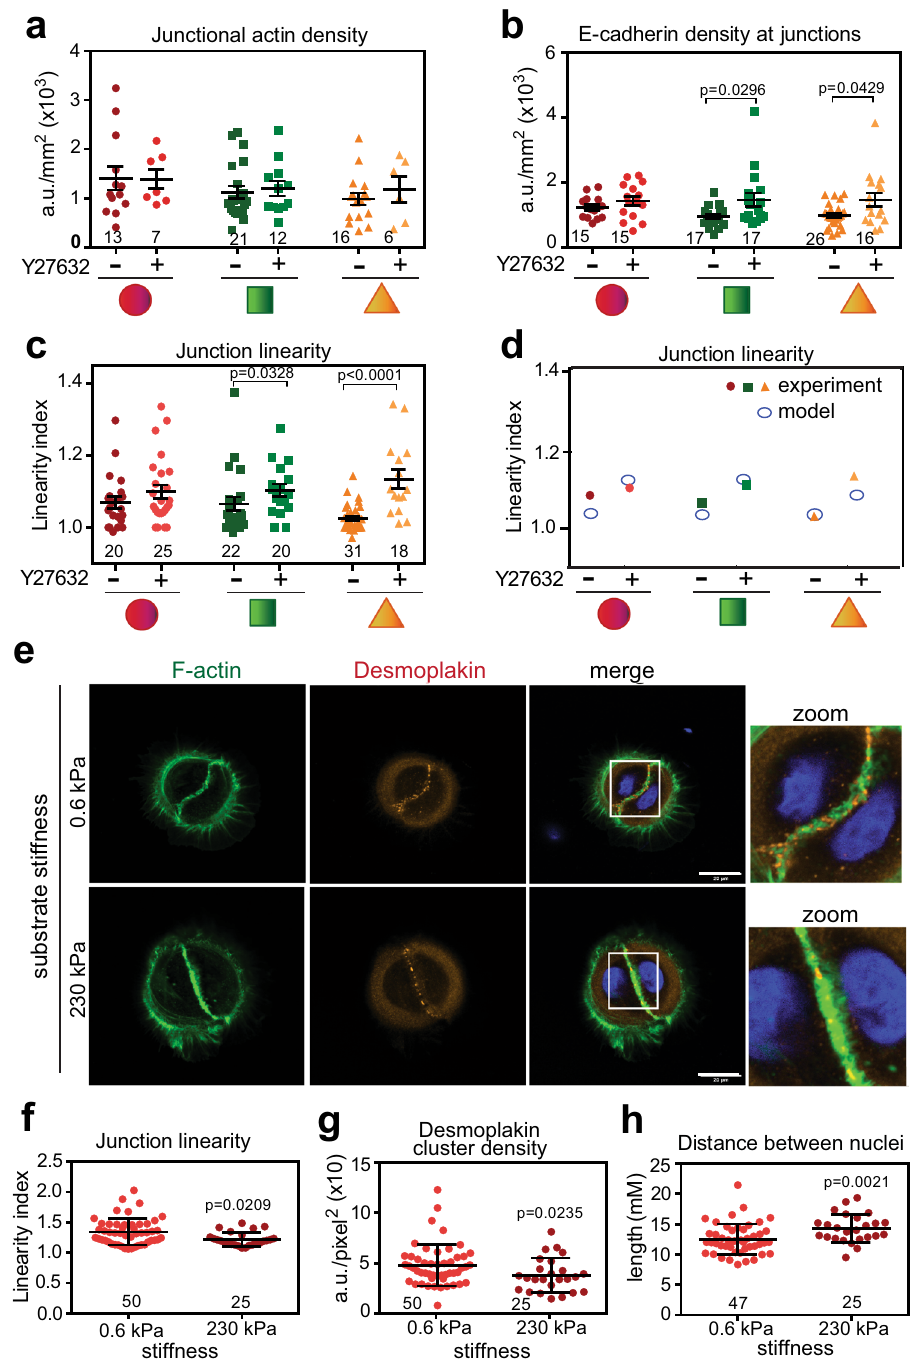
Fig. 8 | Manipulation of intrinsic intracellular rheology is suf fi cient to drive junction maturation phenotype. a – c Con fi ned cell pairs incubated in the pre- sence or absence of Y27632 were stained for E-cadherin or F-actin and images quanti fi ed to obtain density ( a , b ) or junction linearity ( c ) parameters. d Model fi tting shows values obtained for junction linearity from experimental data (solid shapes) and computational modelling (open circles). e – h Keratinocytes were see- ded onto various substrate stiffness on circularmicropatterns with identical areas. Cells were fi xed, stained and distinct parameters quanti fi ed. e Representative images of circular pairs stained for F-actin (green) and desmoplakin (red) as a readout for desmosomal cadherins. Merged images and zoom of the white square